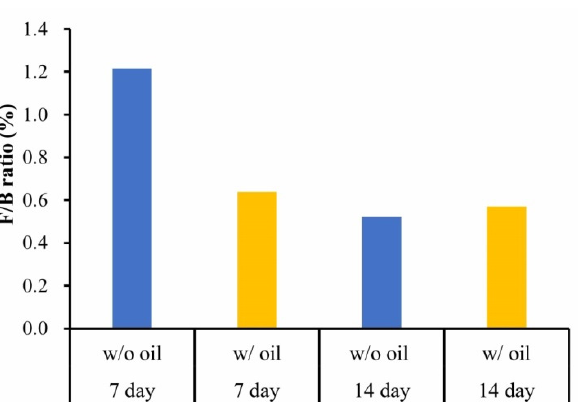
Figure 8. Firmicutes / Bacteroidetes (F/B) ratio from the median on Day 7 and Day 14 between samples treated with and without SM treated with and without SM oil.